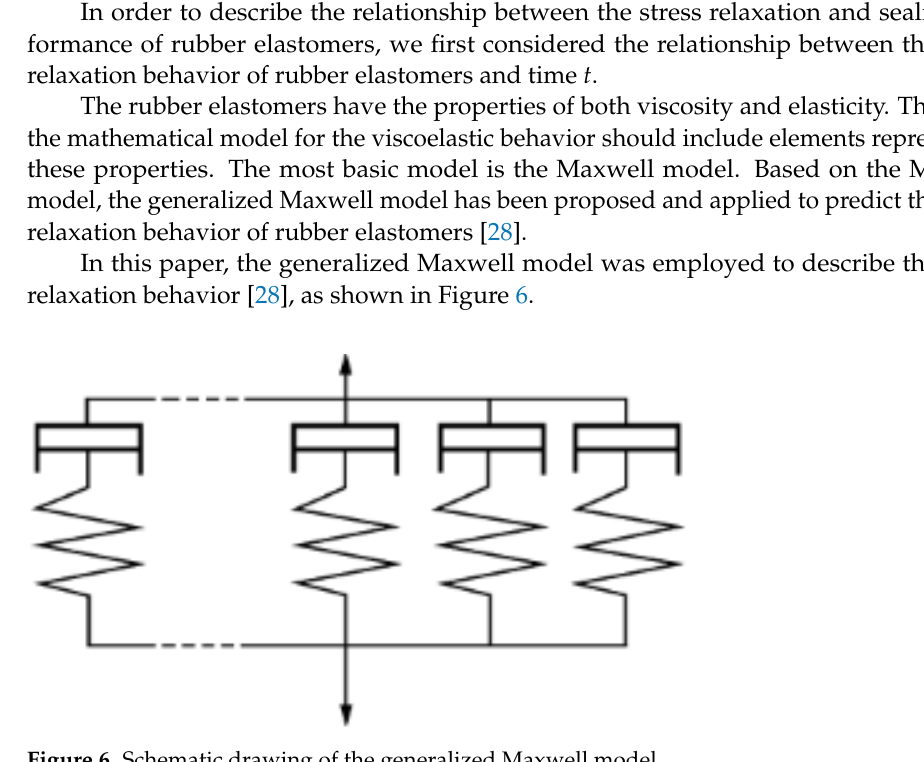
Figure 6. Schematic drawing of the generalized Maxwell model. When the strain is a constant, the relationship between stress and time t can be expressed as n − 1 ∑ σ ( t ) = ε 0 E n + ε 0 i = 1 where σ ( t ) is the stress at time t , ε 0 is the initial strain when t = 0, E n is the elastic modulus of the polymers when they are not affected by viscoelastic behaviors, and τ i and E i are the relaxation time and the elastic modulus corresponding to the i th Maxwell model, respectively. Equation (1) is often called the Prony series, and researchers have proved that it is justified for the stress relaxation behavior of polymeric elastomers [29,30]. The value of the parameters in Equation (1) could be obtained from long-term stress relaxation experiments of rubber elastomers. Furthermore, based on time–temperature superposition (TTS), the experimental results found at high temperature could be used to predict long-term stress relaxation at low temperature [29]. A mathematical model between the actual contact area ratio r and the existence probability P f of leakage channels was presented by Shi, J.C. et al., as shown in Equation (2). zero, and the sealing performance is excellent [4]. Moreover, Dapp, W.B. proposed that the value of r c is about 0.42 by numerical simulations [31]. Additionally, the relationship between the leakage state and r has been widely investigated